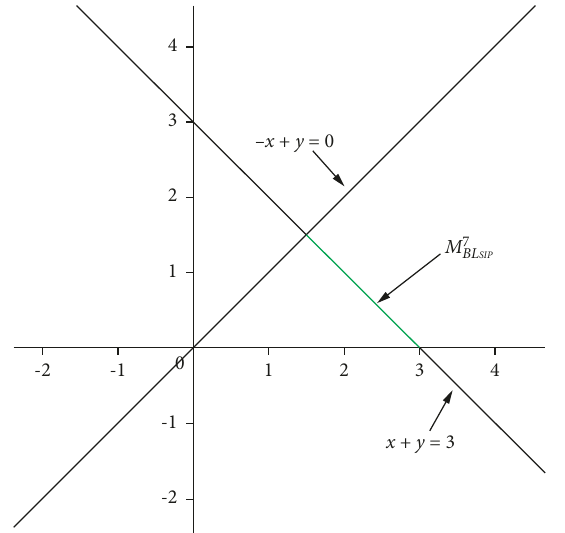
Figure 7: Feasible set of BL